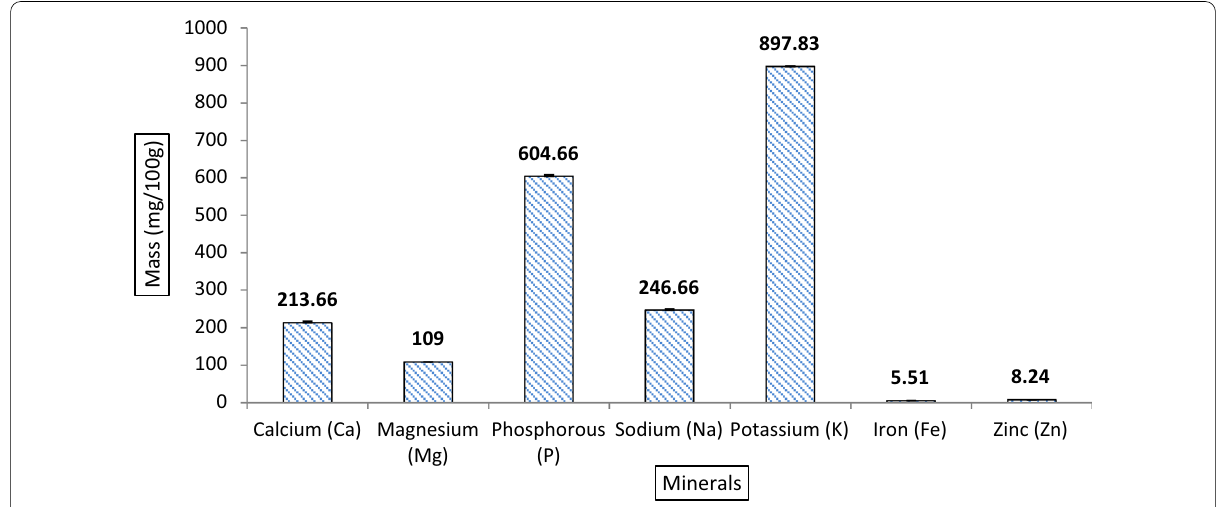
Fig. 2 Graph showing the mineral compositions of Coiblemmus compactus